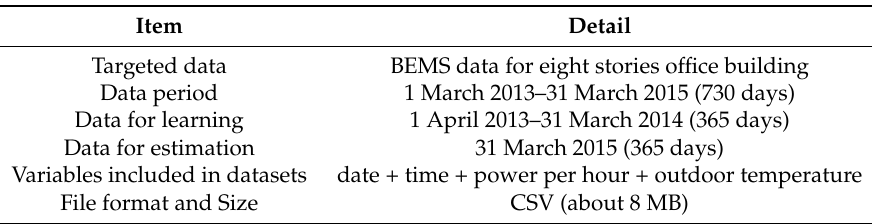
Table 2. BEMS datasets for the estimation.